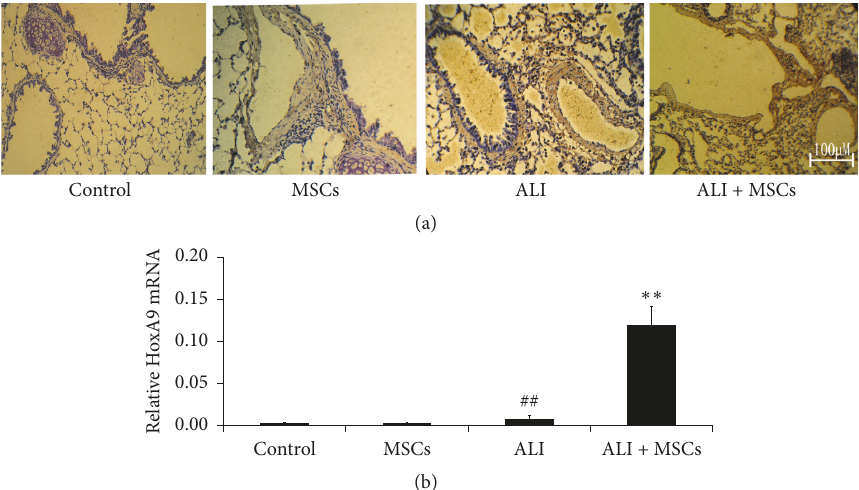
Figure 3: HoxA9 expression in lung was determined by immunohistochemistry (a) and real-time PCR ( 𝑛 = 4 , (b)). HoxA9 expression in the ALI + MSCs group was increased markedly at 24 hours and the increase of HoxA9 expression was significantly distributed in epithelial and endothelial cells. ## 𝑃 < 0.01 versus control; ∗∗ 𝑃 < 0.01 versus ALI.